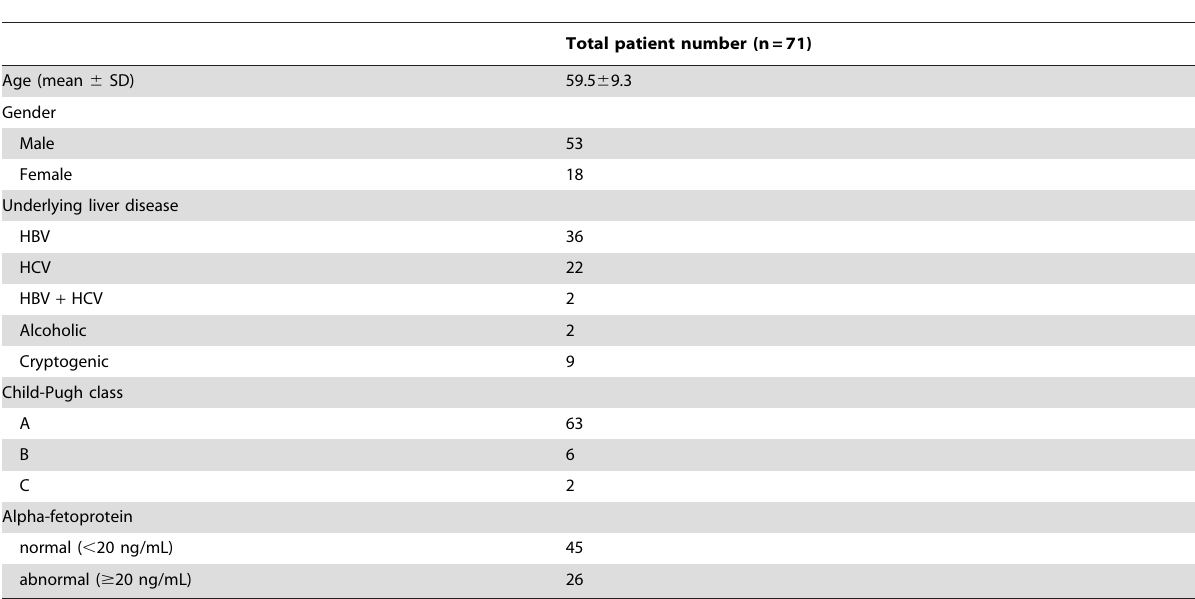
Table 1. Clinical characteristics of the 71 patients with hepatic nodules depitcing atypical AASLD HCC enhancement patterns during dynamic CT